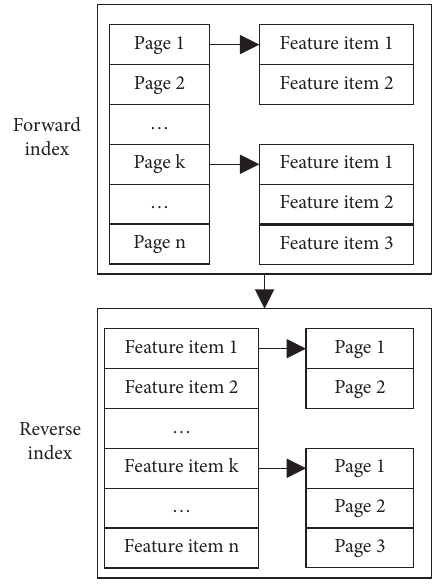
Figure 2: Establishing reverse index from forward